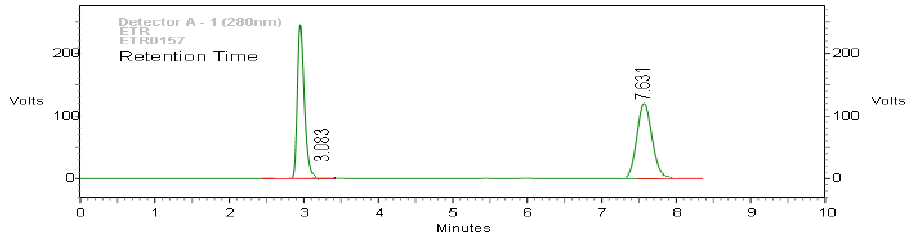
Figure 2. Representative Chromatogram of pure Etoricoxib (20 µg ml -1 ) (Rt = 3.083 mins) with Bromohexine (IS) (10 µg ml -1 ) (Rt = 7.631